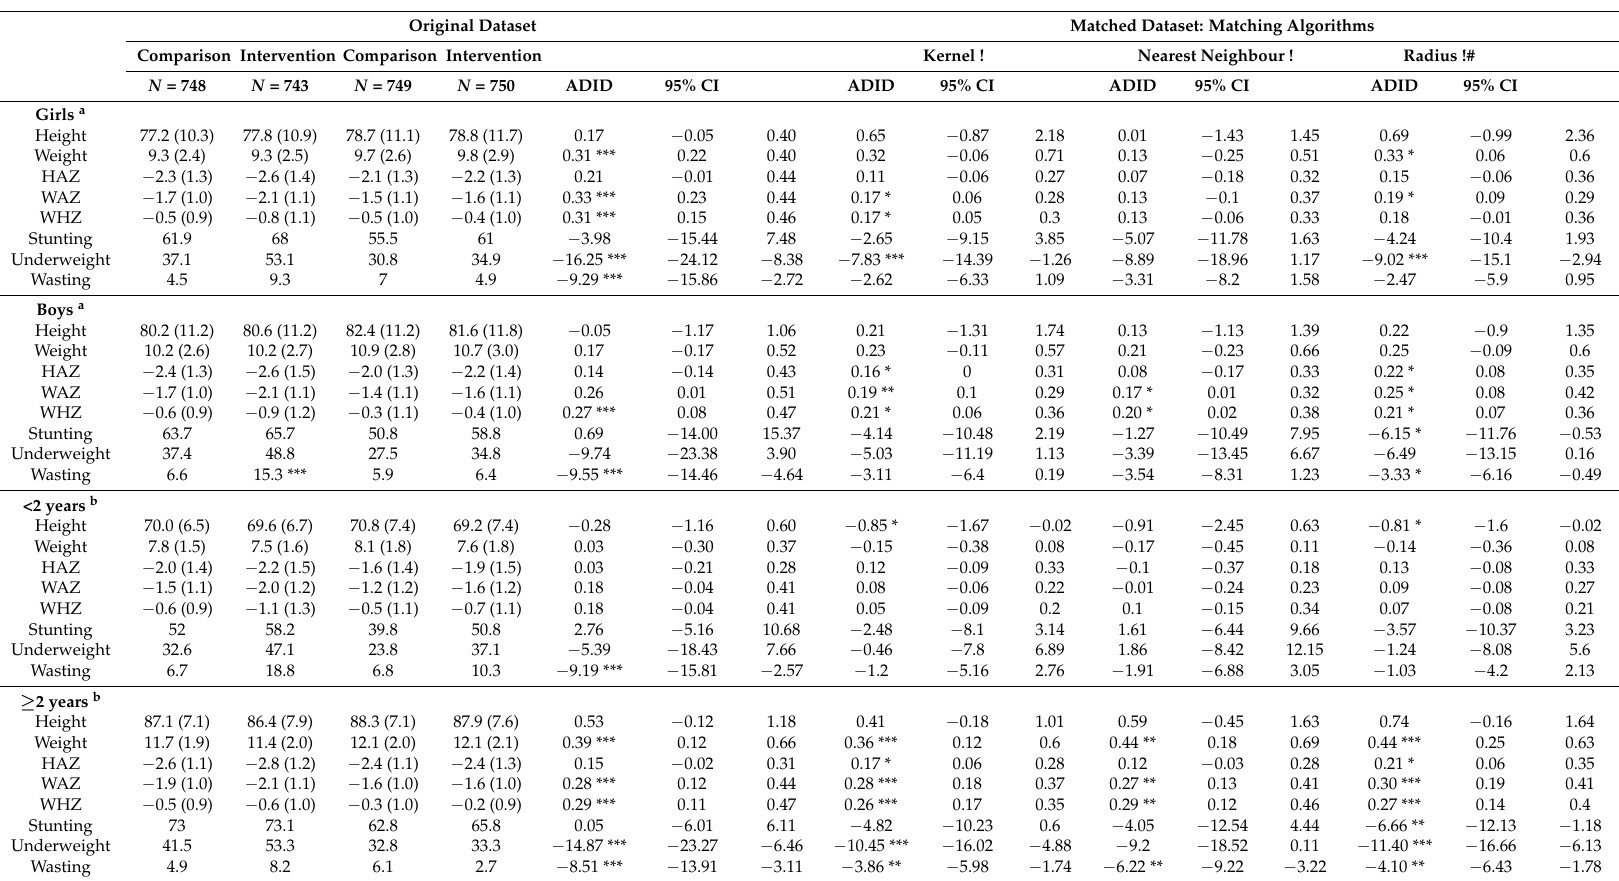
Table 4. Program impact on child